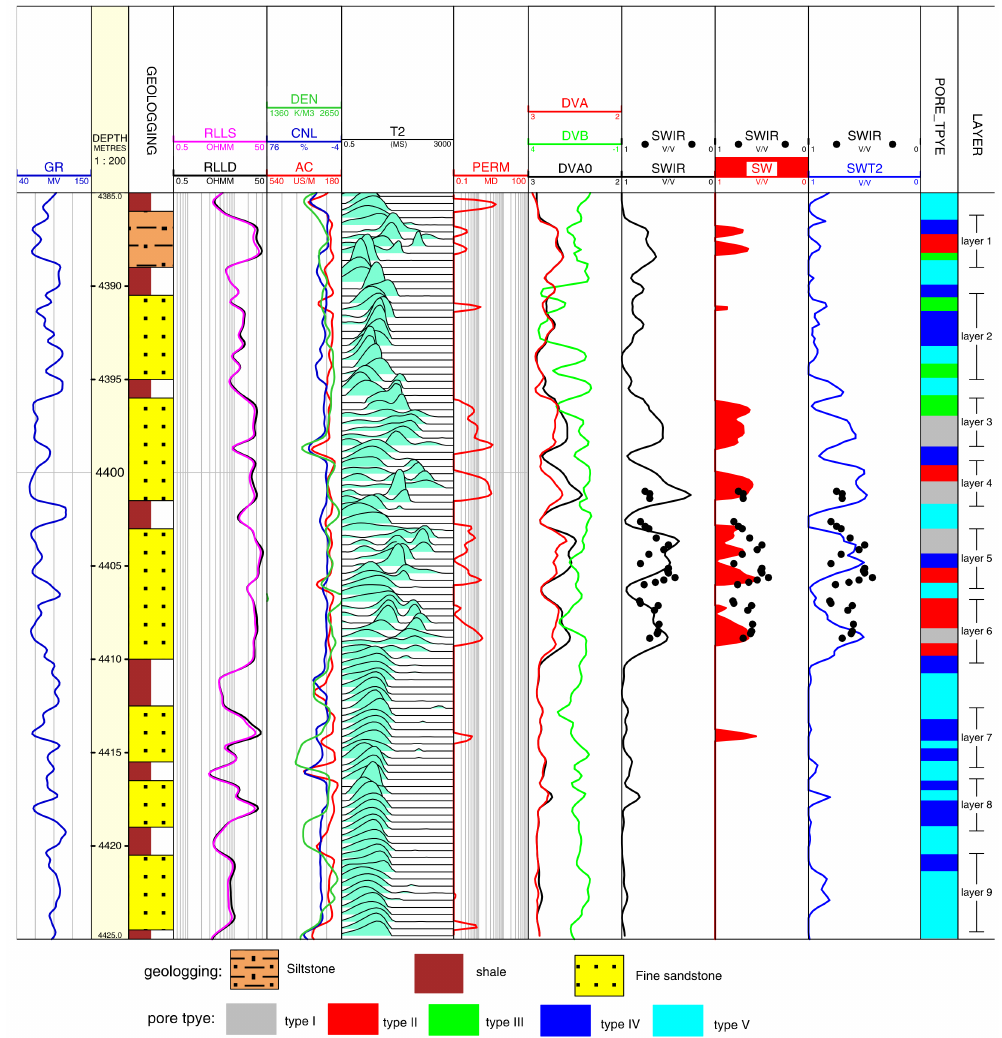
Figure 7. Evaluation result of new methods in Well ×